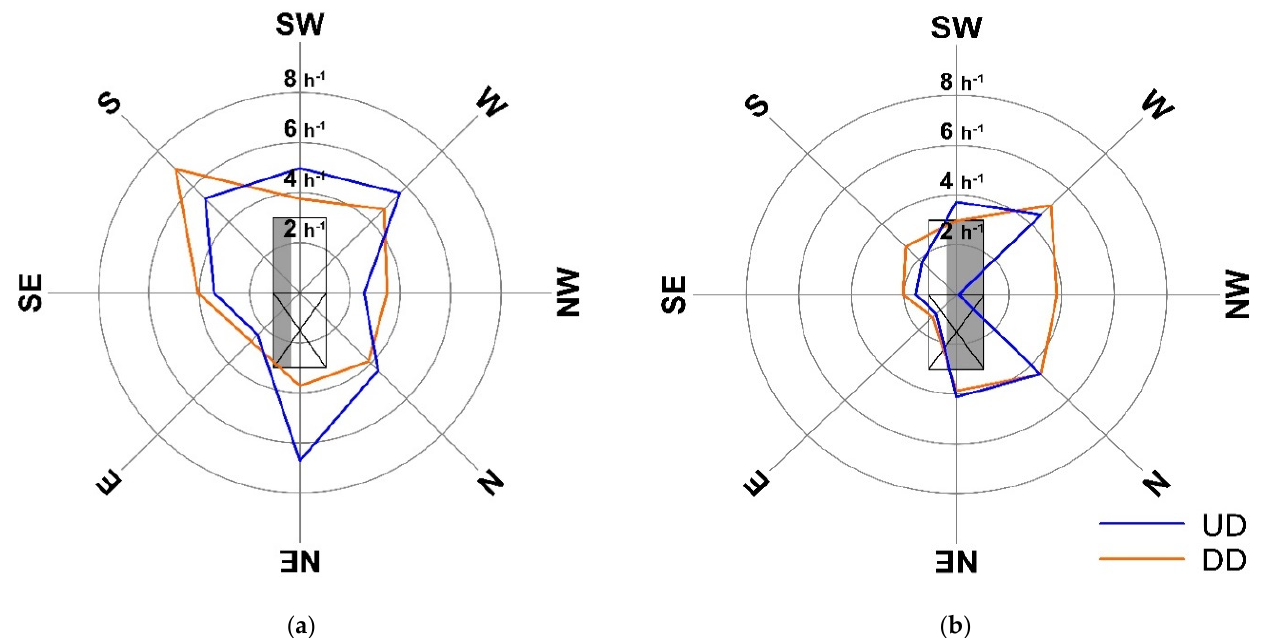
Figure 12. Results of air change per hour [h − 1 ] ( a ) in the cellar and ( b ) in the production hall where grey shows the mentioned area in the sematic figure of the building—Site B with denser but further neighbors.